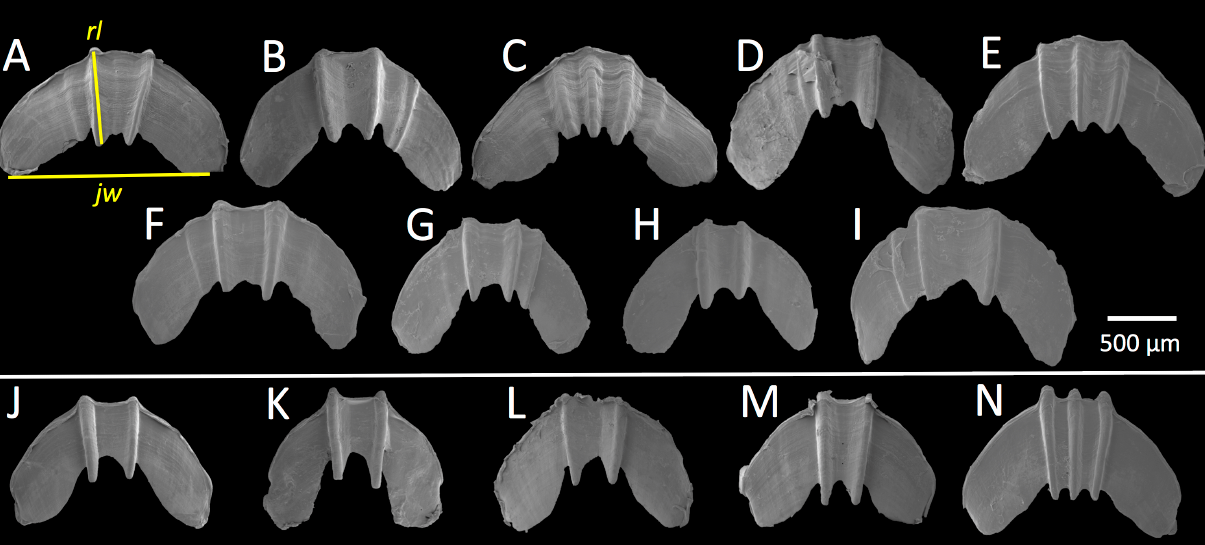
Figure 6. Theba pisana (Müller, 1774) jaws as SEM images from specimens collected in San Pedro, Los Angeles Co. ( A – I ) and San Elijo Lagoon Ecological Reserve, San Diego Co. ( J – N ), California, USA. ( A – B ) From the south entrance of White Point Nature Preserve, 22 June 2020, LACM 182329; (C) from outside the Marine Mammal Care Center, 22 June 2020, LACM 182330; ( D – I ) from White Point Nature Preserve, 17 October 2020, LACM 182342; and ( J – N ) from San Elijo Lagoon Ecological Reserve, 12 September 2020, ( J ) LACM 182335, ( K – N ) LACM 182334. Measurements of jaw width (jw) and jaw ridge length (rl) are indicated in ( A ). Table 2. Estimates of K2P genetic distance in Theba pisana CO1 mtDNA within and between sites in California (San Pedro, Los Angeles County and San Elijo Lagoon Ecological Reserve, San Diego County) and elsewhere in the world (see Figure 8C).